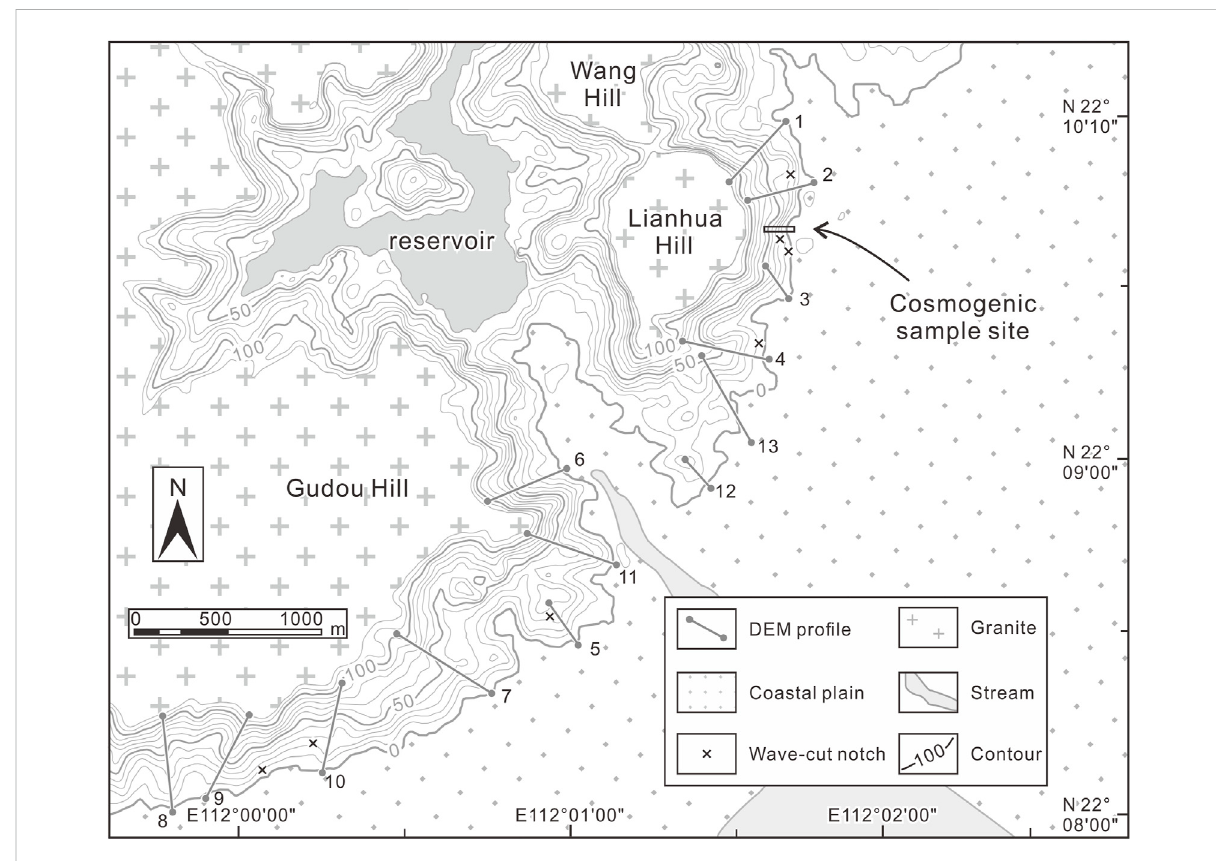
FIGURE 2 Simpli fi ed topographic and geological map of the study area. Locations of topographic pro fi les 1 to 13 and the 10 Be cosmogenic sampling site are shown with a 10-m topographic contour spacing interval ranging from 0-m to 120-m at